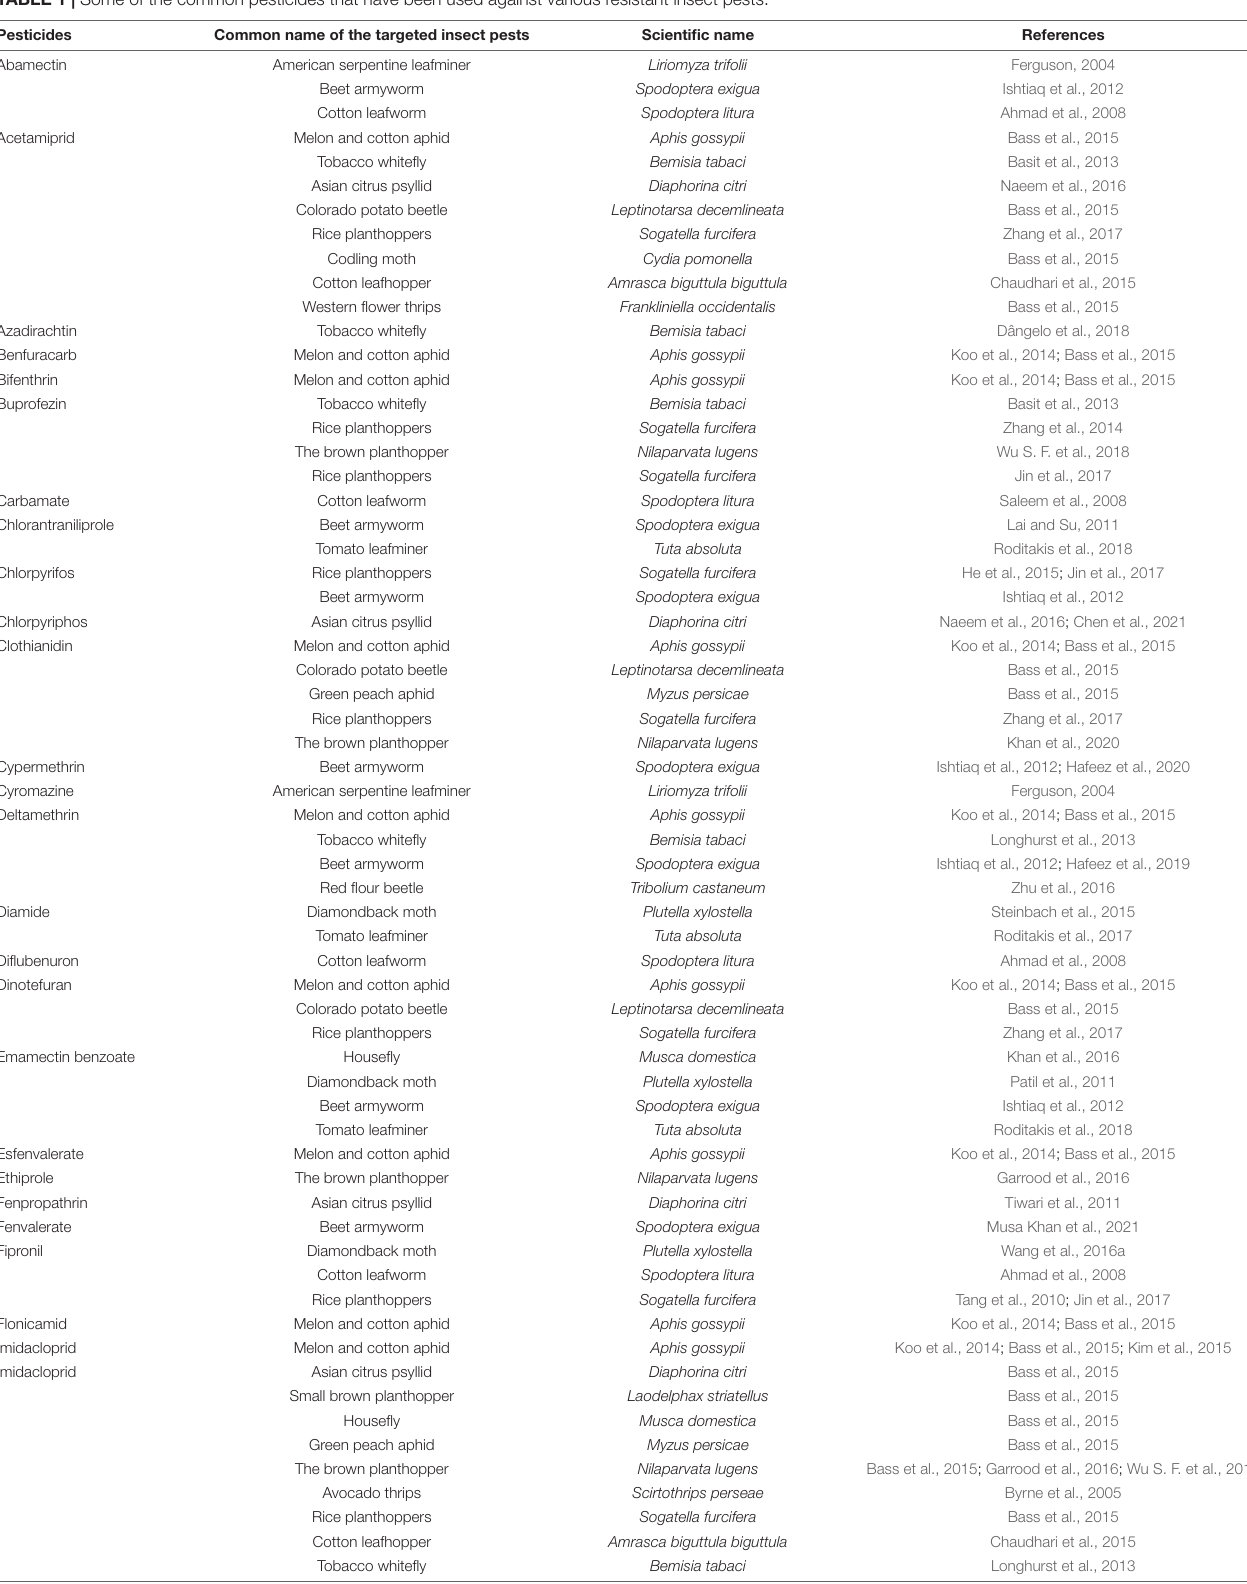
TABLE 1 | Some of the common pesticides that have been used against various resistant insect